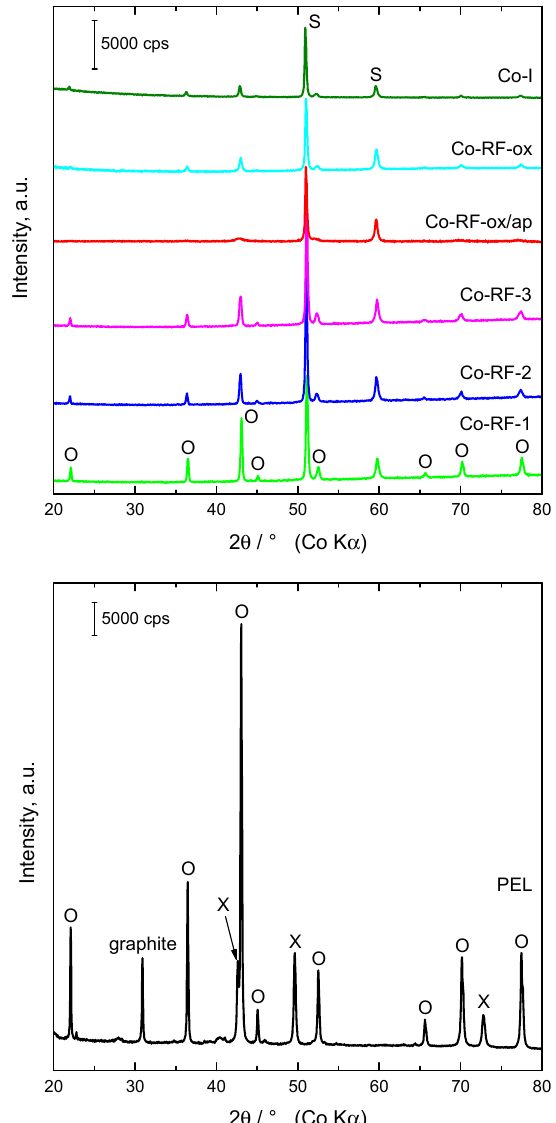
Figure 1. Powder XRD patterns of the cobalt oxide catalysts prepared over meshes and the pelletized commercial Co 3 O 4 (the PEL sample below). O—Co 3 O 4 , S—stainless-steel support, X—CoO.